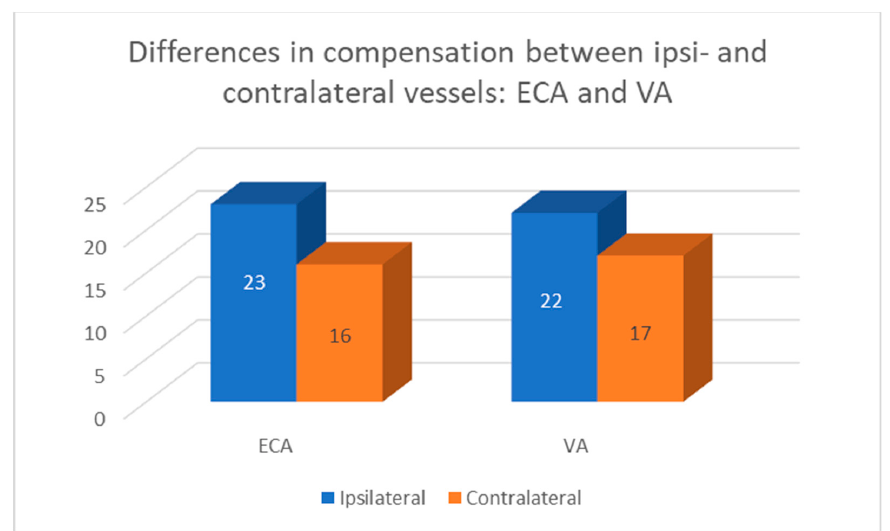
Figure 3. The percentage of patent arteries with and without flow compensation. The compensatory increased flow volume was most frequently observed in the contralateral ICA—54.76%, in 48.91% of ECAs, and in the 51.09% of VAs. The compensatory increased flow was more frequently observed in ipsilateral vessels than in contralateral ones—see Figure 4.